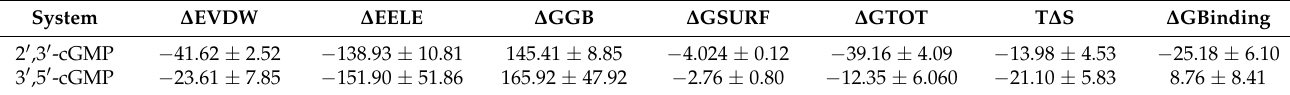
Table 1. Binding free energies (kcal/mol) for CNPase with 2 (cid:48) ,3 (cid:48) -cGMP and 3 (cid:48) ,5 (cid:48) -cGMP.